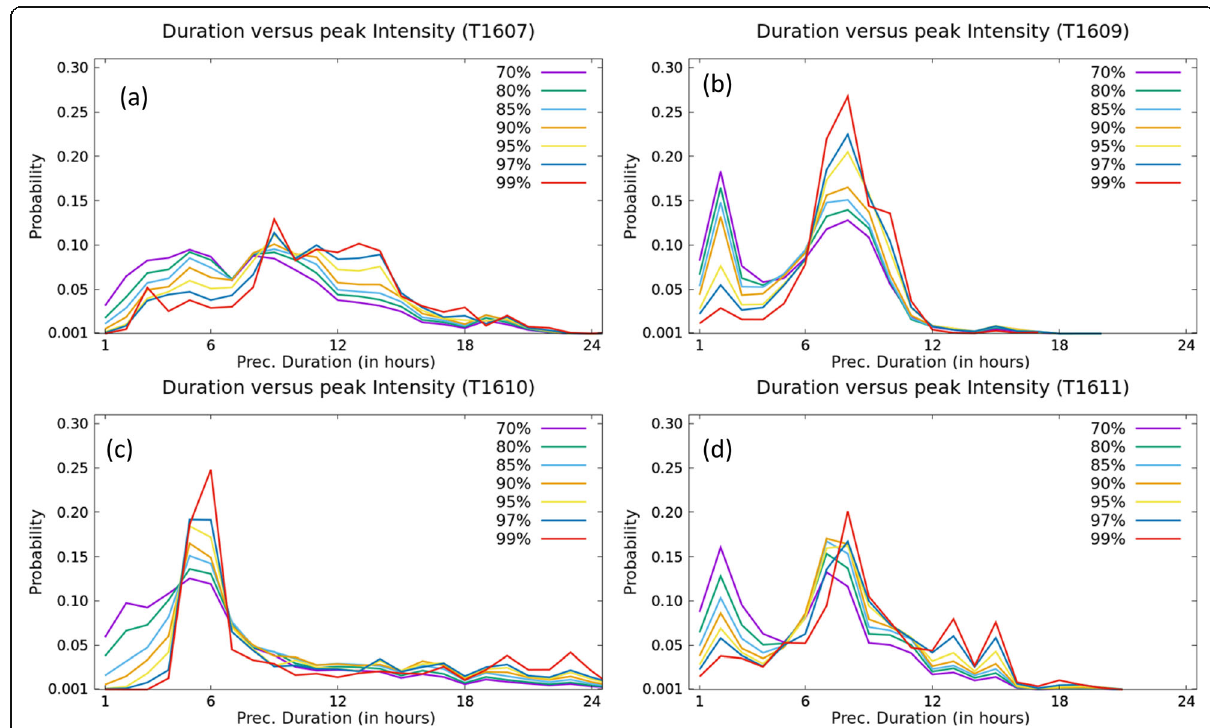
Fig. 6 Duration-intensity characteristics from a Typhoon Chanthu, b Typhoon Mindulle, c Typhoon Lionrock, and d Typhoon Kompasu. Results correspond to the